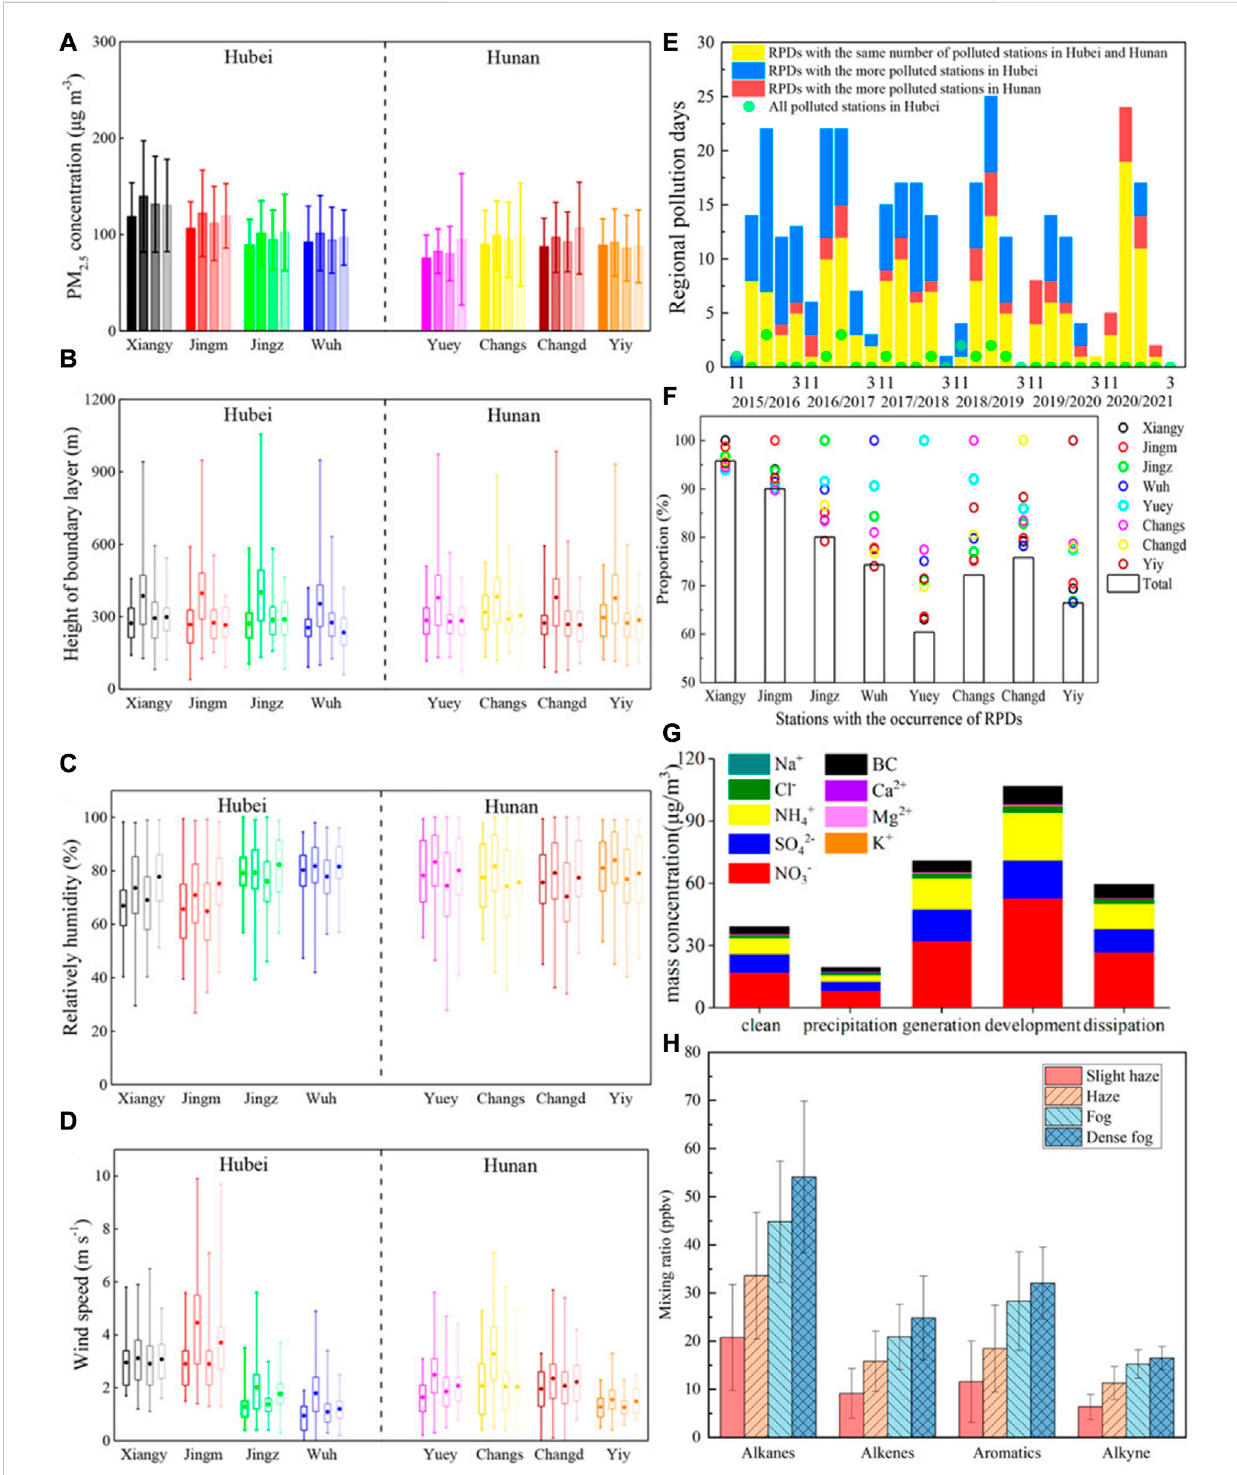
FIGURE 1 Distribution of (A) PM 2.5 concentration, (B) boundary layer height, (C) relative humidity and (D) wind speed under four weather types for regional pollutiondays(RPDs)ateightstationsinHubeiandHunanprovinces.Thecentralboxrepresentsthevaluesfromthelowertoupperquartiles(25thto75th percentiles), and the vertical line extends from the minimum to the maximum. The middle solid dot represents the mean value. (E) Variation of RPDs and the differential distributions of polluted stations during RPDs in Hubei and Hunan. The green dots show all polluted stations located in Hubei during RPDs. (F) Proportions of pollution days at eight stations to the total RPDs and the occurrence of pollution days at each station. (G) Mass concentration of inorganic components under different stages of RPDs. (H) Average volume fractions of each component in atmospheric VOCs during different weather conditions. Adapted from Yue et al., Diao et al. and Zhao et